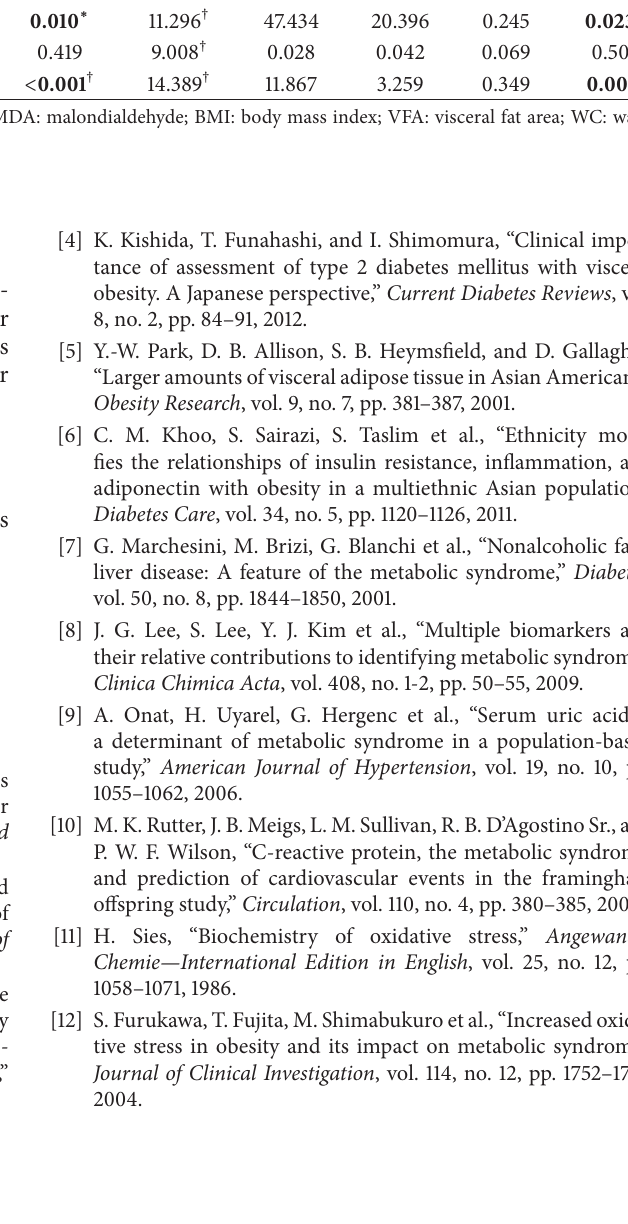
Table 4: Multiple regression analysis of associations between abdominal visceral fat area and metabolic parameters. Adjusted BMI 𝑃 Adjusted BMI and WC 𝑃 Abdominal VFA value value 𝐹 𝐵 SE 𝛽 𝐹 𝐵 SE 𝛽 † GGT 14.03 0.106 0.047 0.230 0.028 ∗ 10.70 † 0.095 0.047 0.207 0.046 ∗ Uric acid 12.43 † 5.703 3.240 0.185 0.083 10.23 † 4.680 3.196 0.152 0.148 CRP 15.34 † 53.703 20.231 0.278 0.010 ∗ 11.296 † 47.434 20.396 0.245 TG 11.17 † 0.035 0.043 0.086 0.419 0.028 0.042 0.069 0.507 Urinary MDA 19.37 † 12.321 3.301 0.362 14.389 †